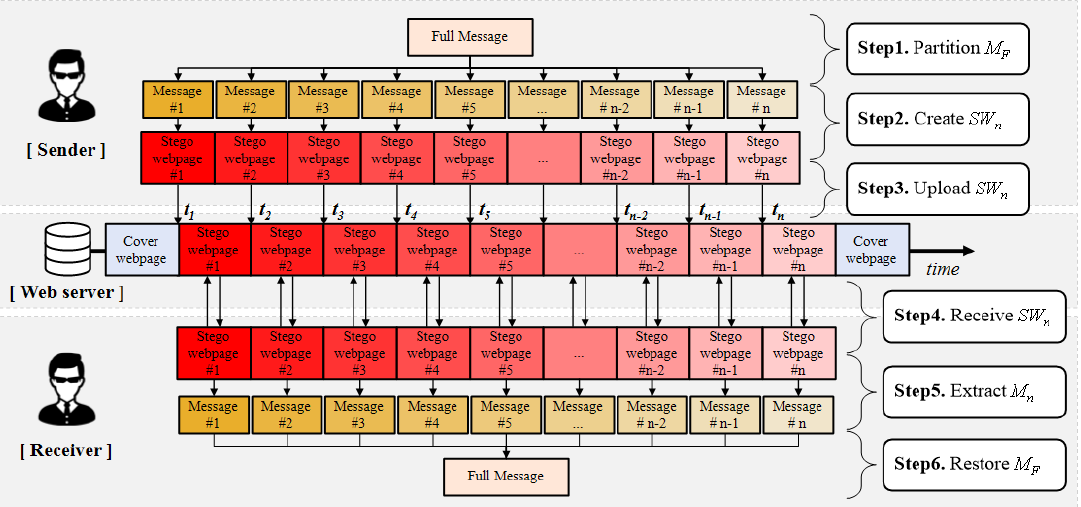
Figure 7. Working steps of Time-based Dynamic Operation Algorithm for hiding Capacity (TDOA- C).